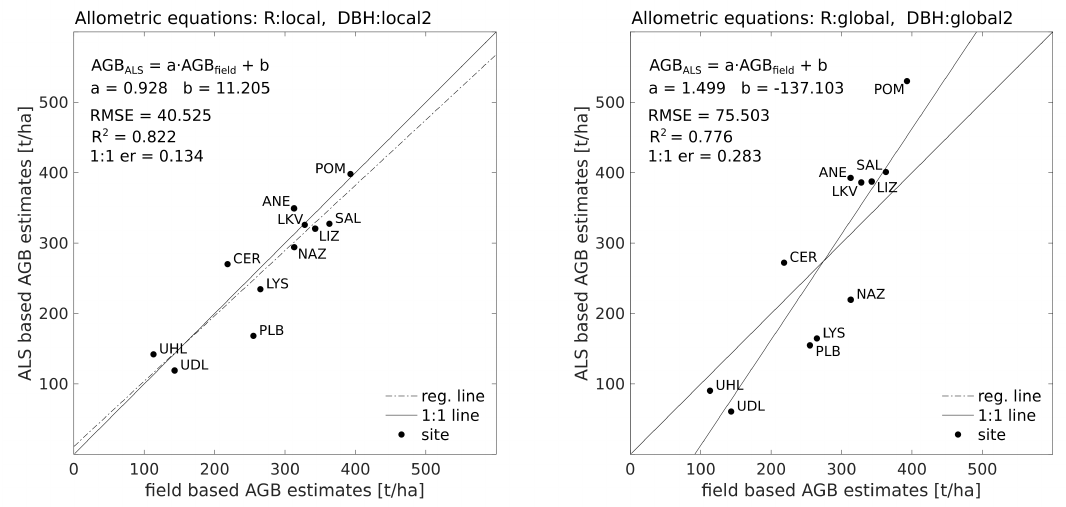
Figure 8. Comparison of total AGB for entire catchment areas based on estimates obtained from field data and from ALS data using local allometric equations ( left ) and global allometric equations ( right ). Linear regression line (dashed) is presented together with a 1:1 line